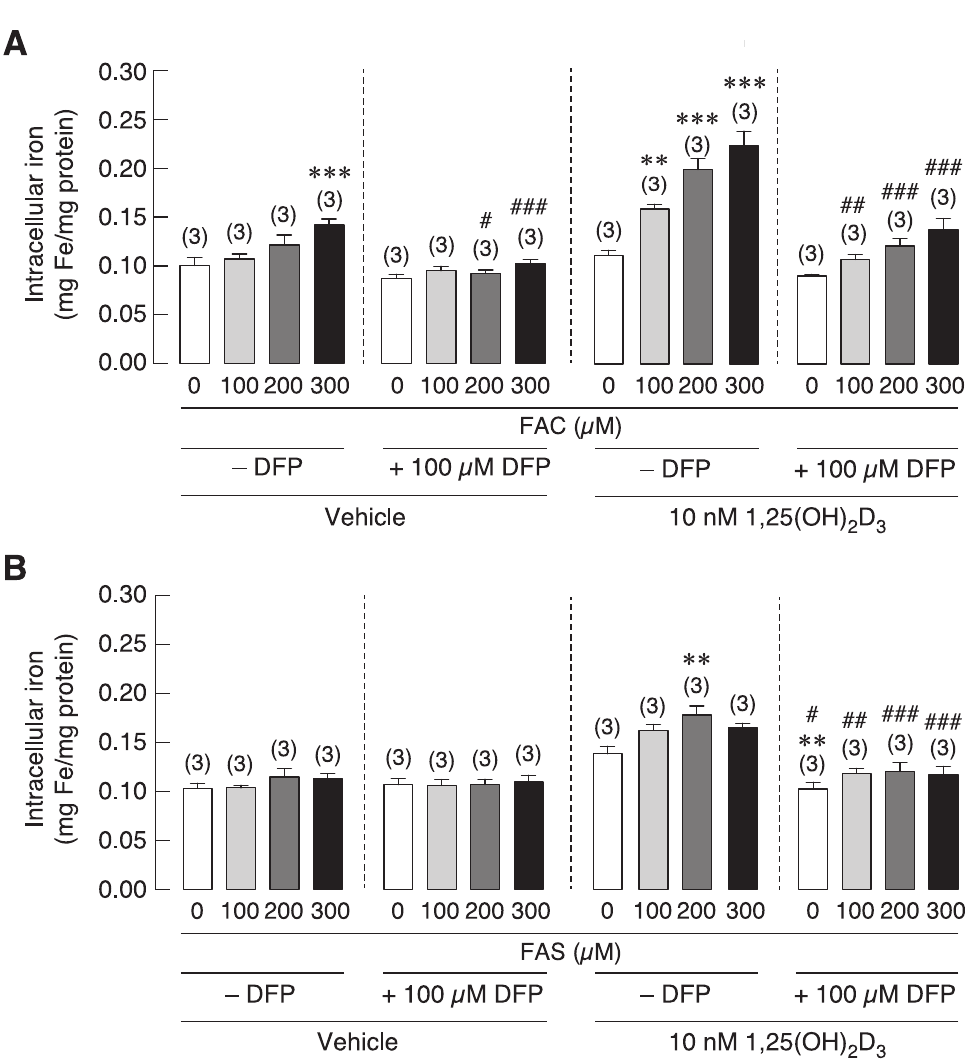
Fig 5. Intracellular iron in osteoblast UMR-106 cells after treated with (A) FAC and (B) FAS under the stimulation of vehicle control or 1,25(OH) 2 D 3 in the presence or absence of deferiprone (DFP). DFP significantly reduced intracellular iron in osteoblasts treated with FAC and FAS. The more profound reduction was observed in the groups under